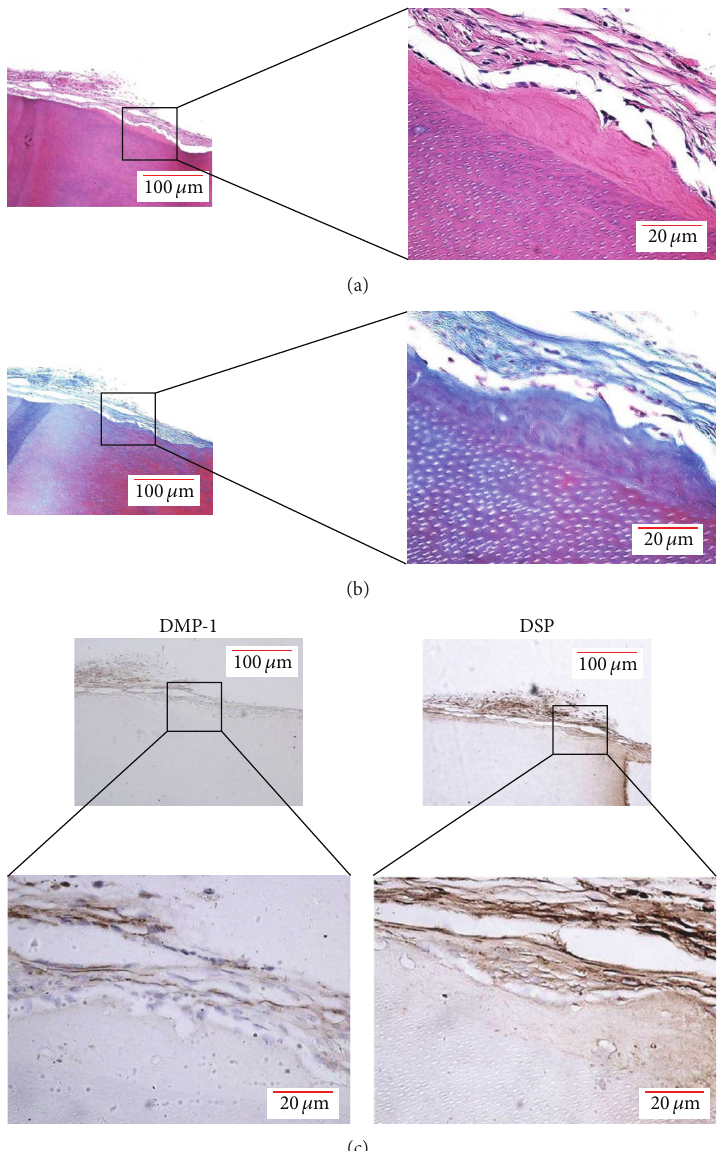
Figure 5: hTDM induces hUCMSCs into odontoblast-like cells in vivo . (a) HE staining of hTDM-hUCMSC composites after subcutaneous implantation into nude mice for 8 weeks. (b) Masson’s tricolor staining of hTDM-hUCMSC composites after subcutaneous implantation into nude mice for 8 weeks. (c) Newly formed calcification and adhesive cells on hTDM were positive for DSP and DMP-1 as detected by